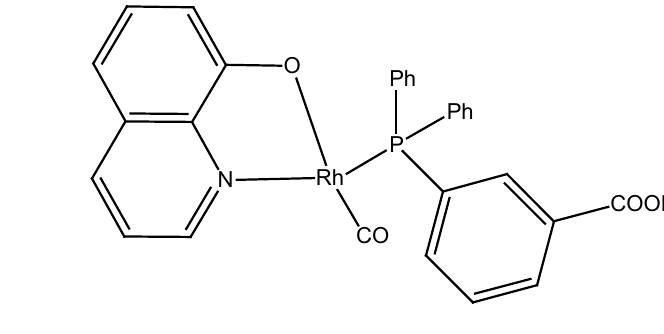
Figure 3. [Rh(quin-8-O)(CO)(Ph